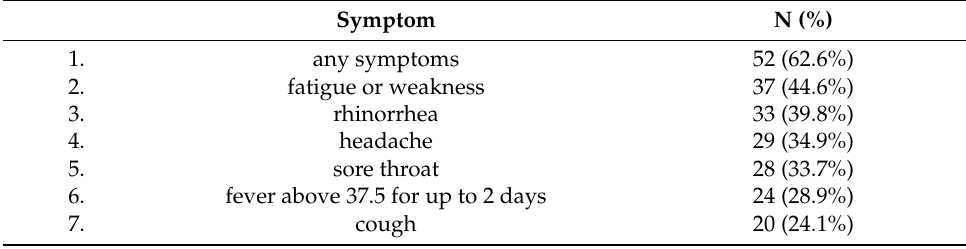
Table 4. Breakthrough COVID-19